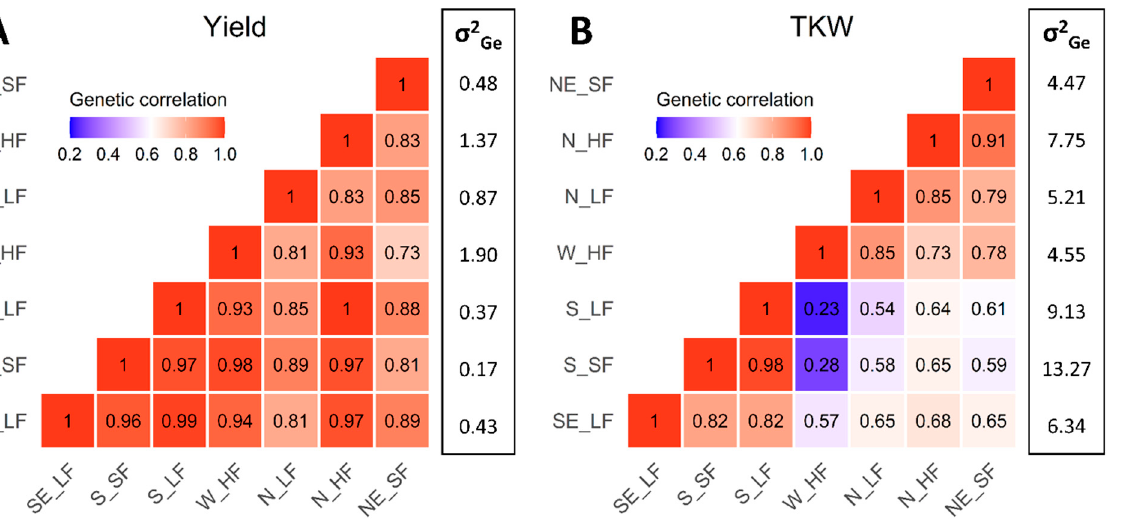
of each environment are indicated in the column Ge